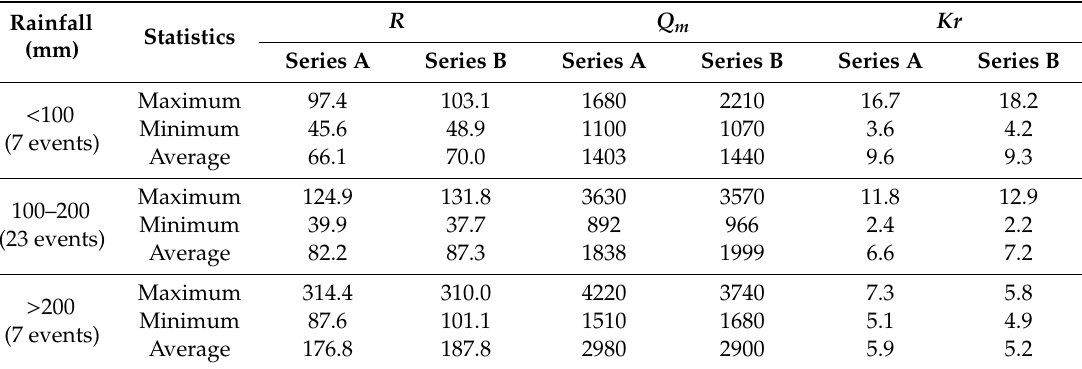
Table 9. The result of hydrologic variables of di ff erent rainfall in Dapoling